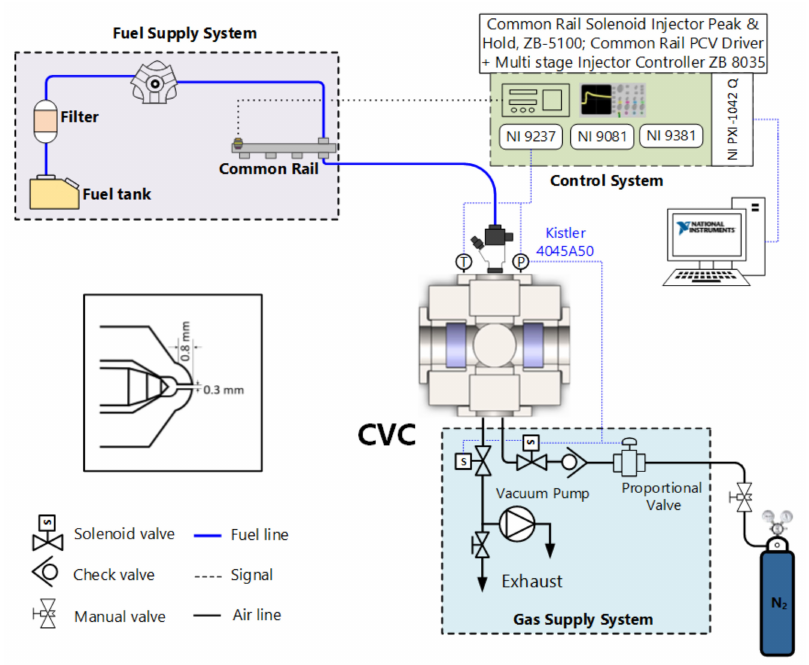
Figure 1. Schematic diagram of the experimental setup (the fuel injection system and the constant-volume